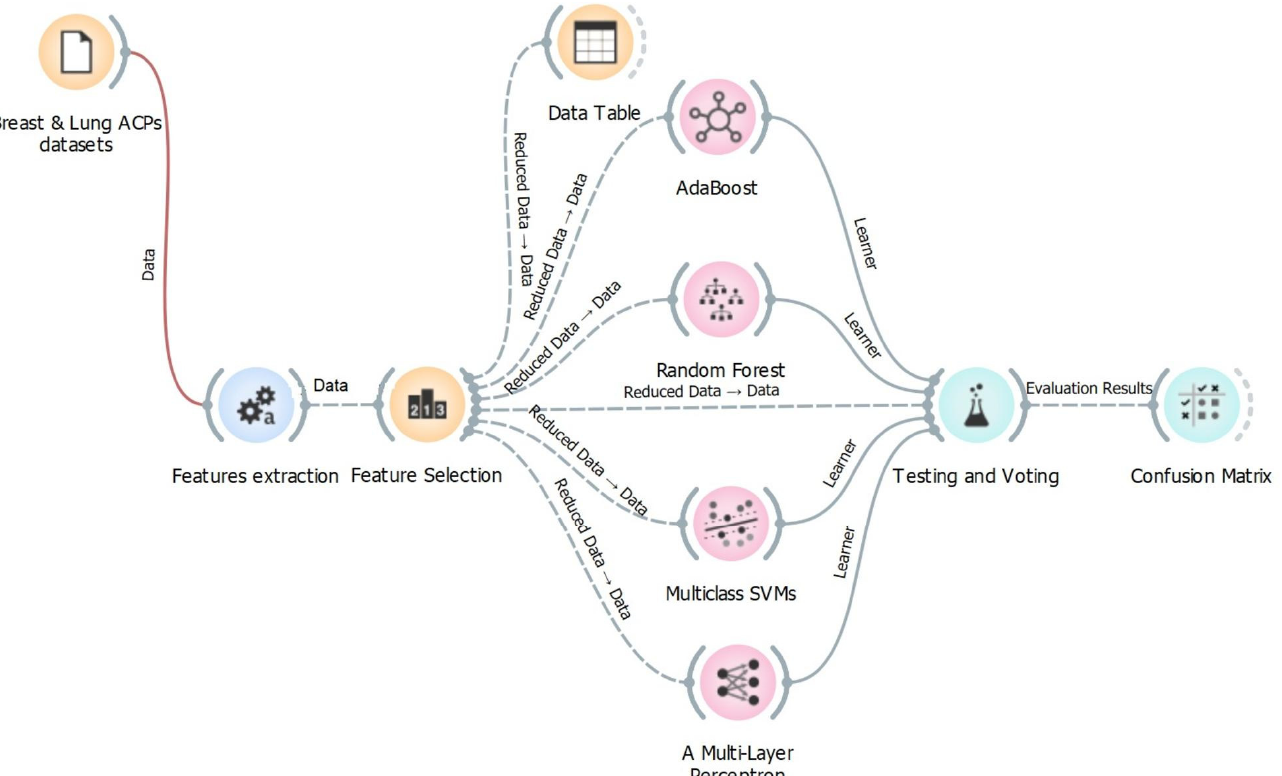
Figure 2. The architecture of the proposed model.